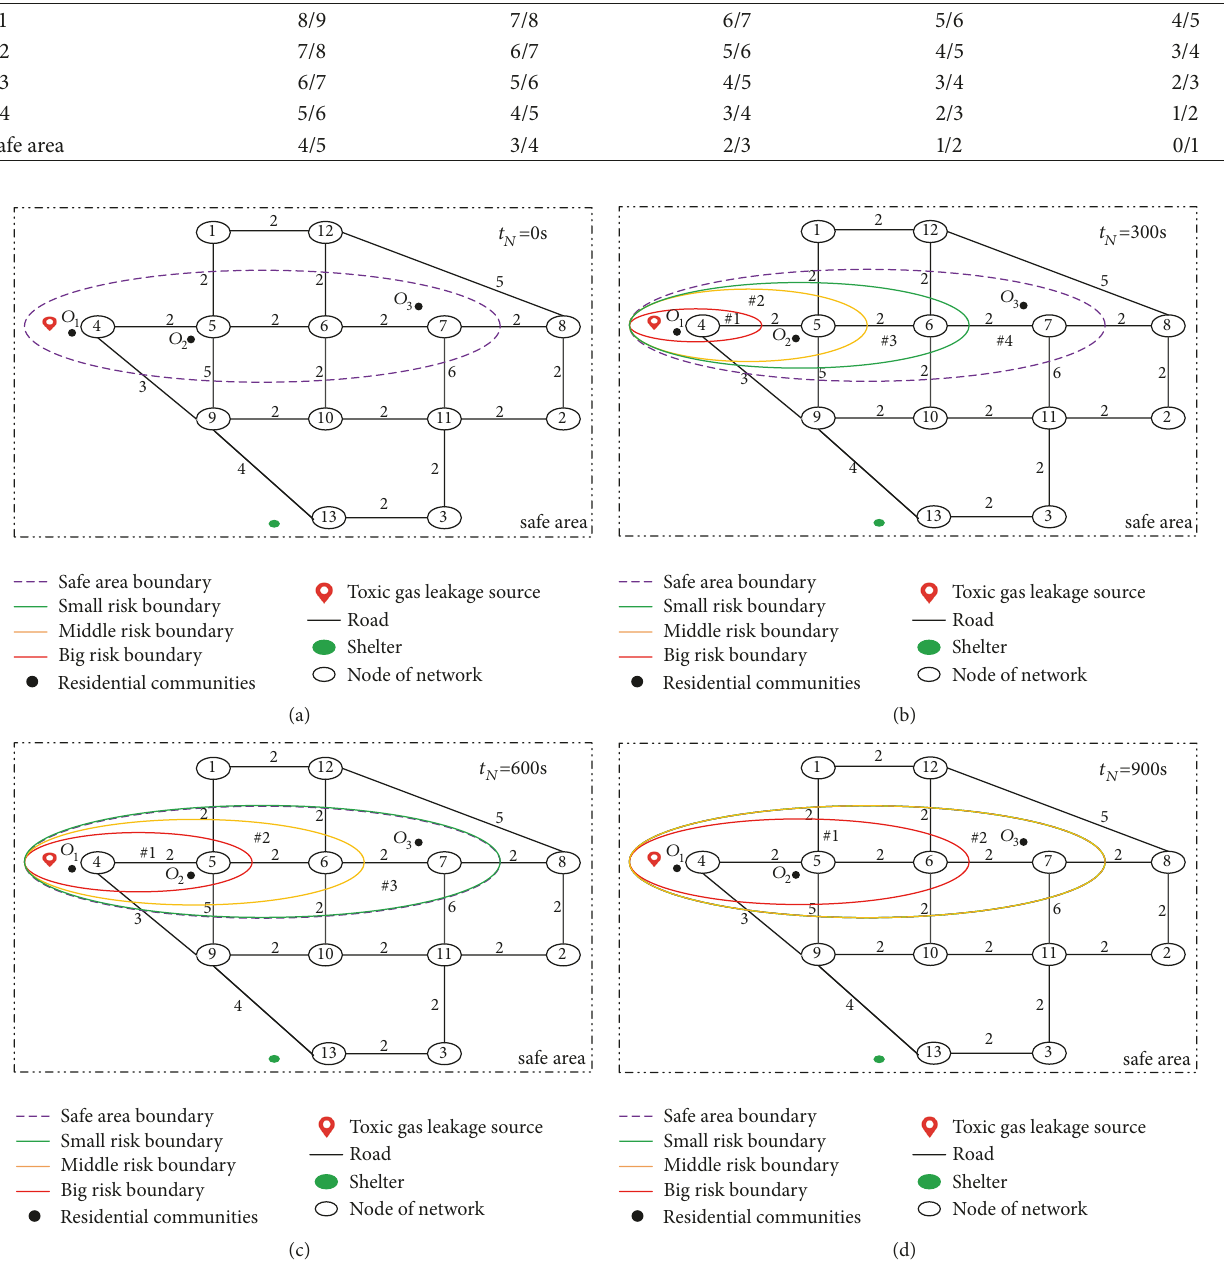
oblique line are road risk level. The right stands for